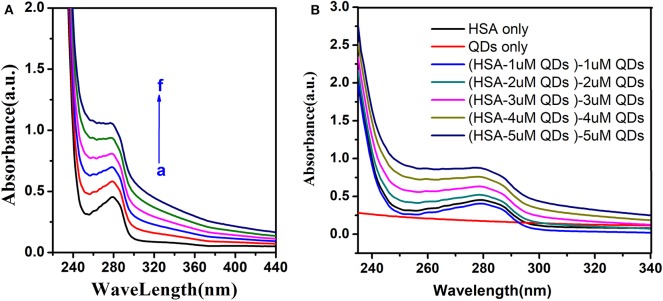
(A) Uv-visible absorption spectra of HSA (T = 298 K) in different concentration of AIZS-GO QDs. c(HSA) = 1.0 × 10−6molL−1, c(AIZS-GO QDs): (a-f): 0, 1, 2, 3, 4, 5 × 10−6molL−1, pH = 7.4. (B) is the Uv-visible absorption spectra of QDs, HSA and the distinction of HSA-QD and QDs.